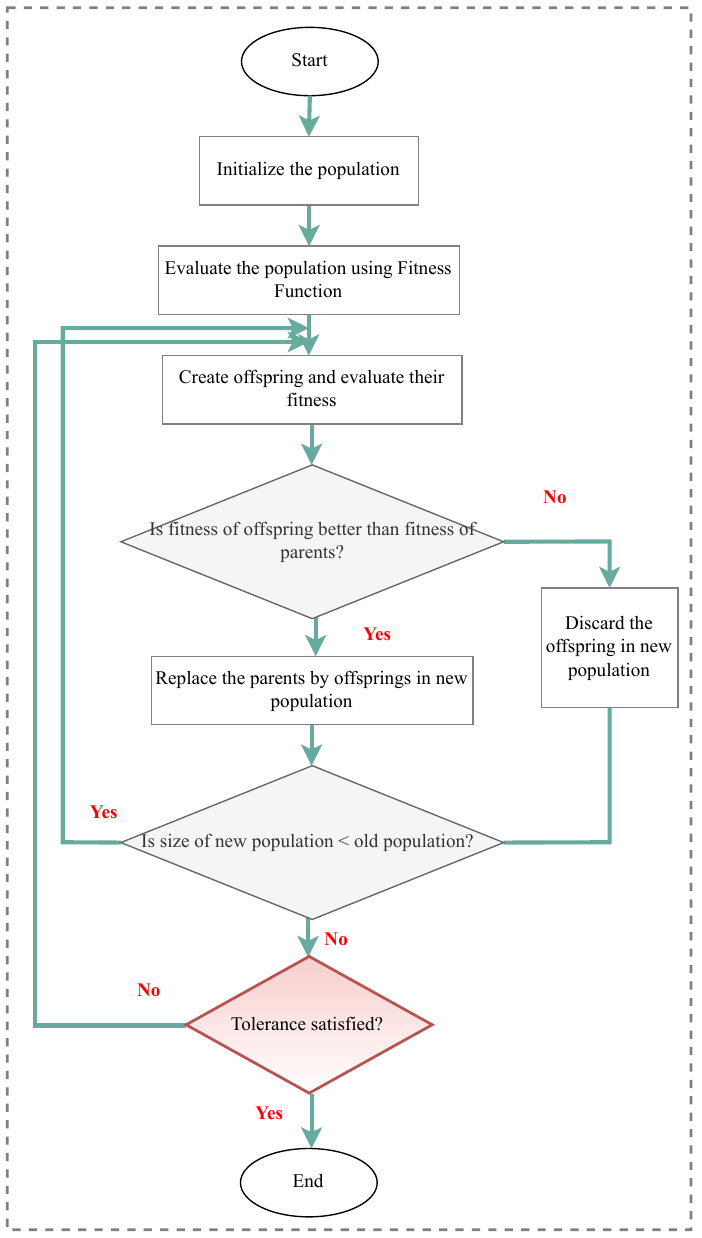
Figure 13. Flowchart of DE